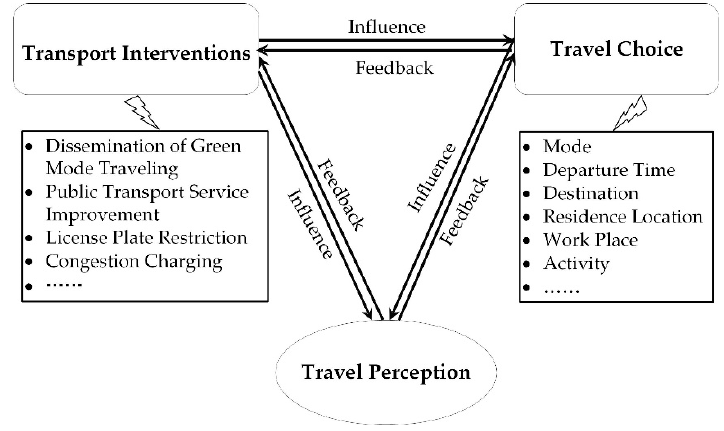
Figure 1. Relationship among transport interventions, travel choice, and travel perception.